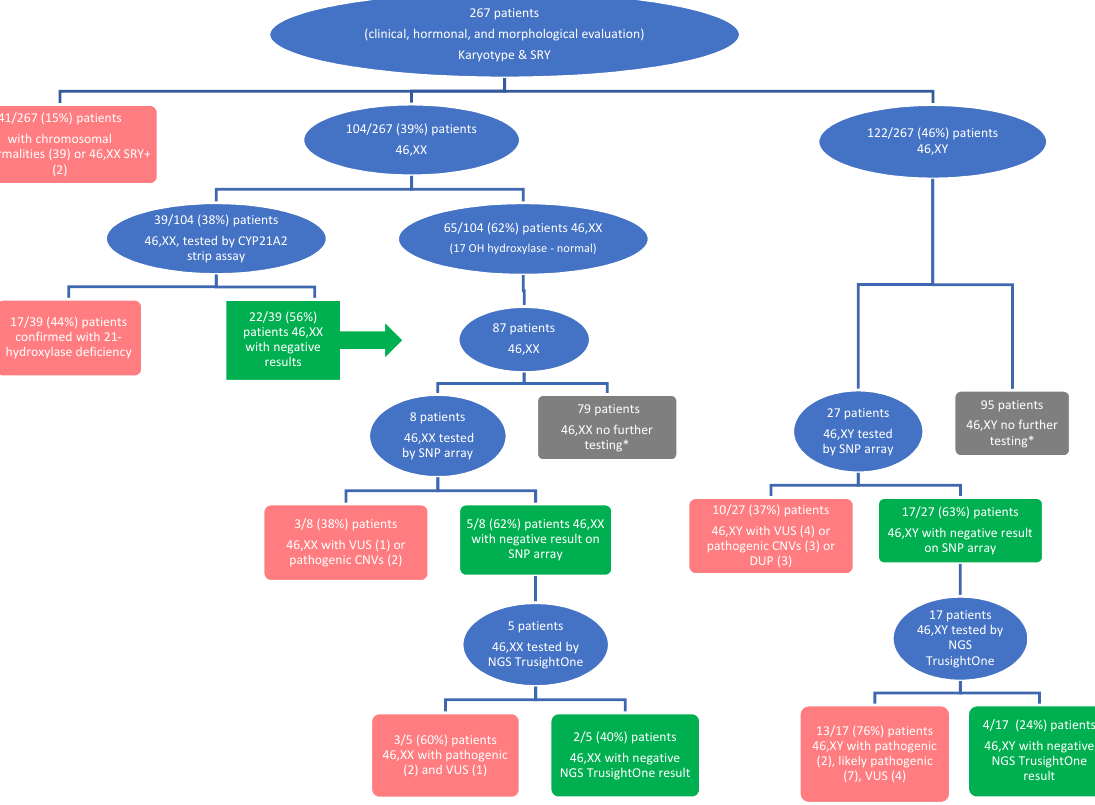
Figure 1. The investigation protocol for genetic testing in the study group. (* The patients were not further tested due to the absence of clinical monitoring after their first medical visit).